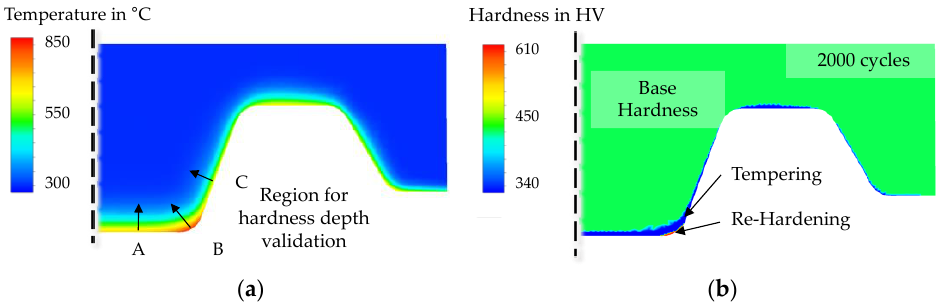
Figure 12. Numerical calculation of ( a ) the temperature field at the end of the forming step and ( b ) a hardness field exemplarily shown for 2000 cycles.